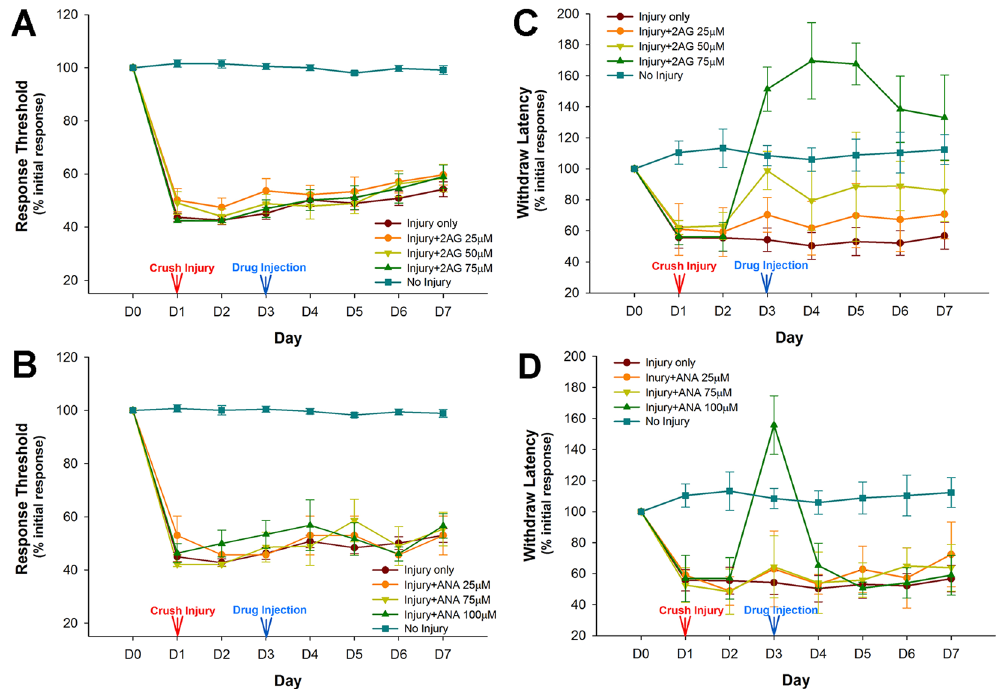
Figure 3. Effect of endocannabinoids on Hirudo that had undergone injury-induced sensitization. Hirudo were given a crush injury to the posterior sucker and tested for changes in responsiveness to nociceptive and non-nociceptive stimuli for seven days. ( A , B ). Crush injury to the posterior sucker sensitized these animals to non-nociceptive mechanical stimuli. Neither 2-AG (25, 50, 75 μ M) nor anandamide (50, 75, 100 μ M) affected responses to non-nociceptive mechanical stimuli. ( C , D ) This same injury sensitized animals to nociceptive chemical stimuli (AITC). This sensitization was reduced by 100 µ M 2-AG and 50 µ M 2-AG. 25 µ M had no effect. Anandamide was also capable of reducing this injury-induced sensitization, but only at the highest concentration (75 µ